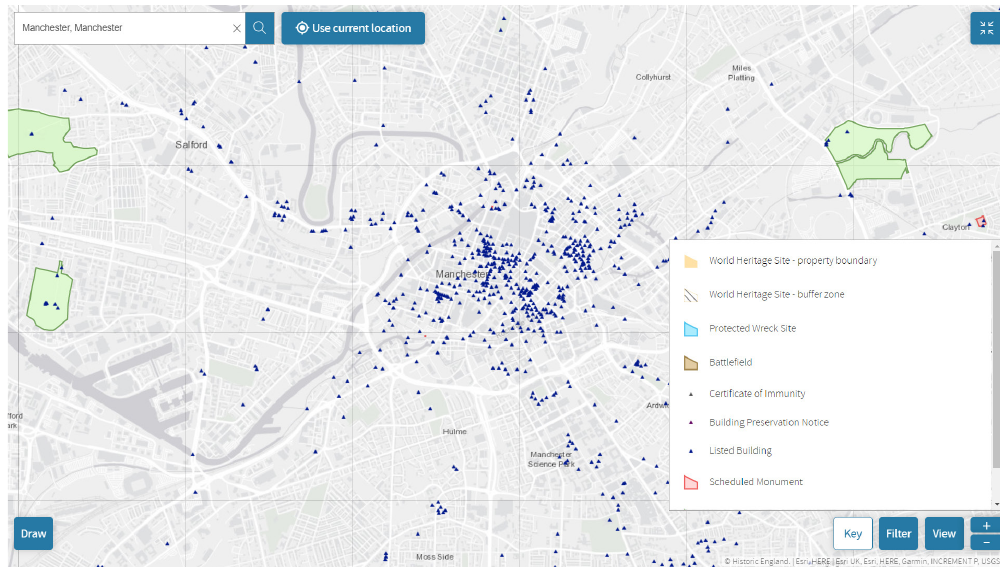
Fig. 1 The Cultural Heritage GIS of Historic